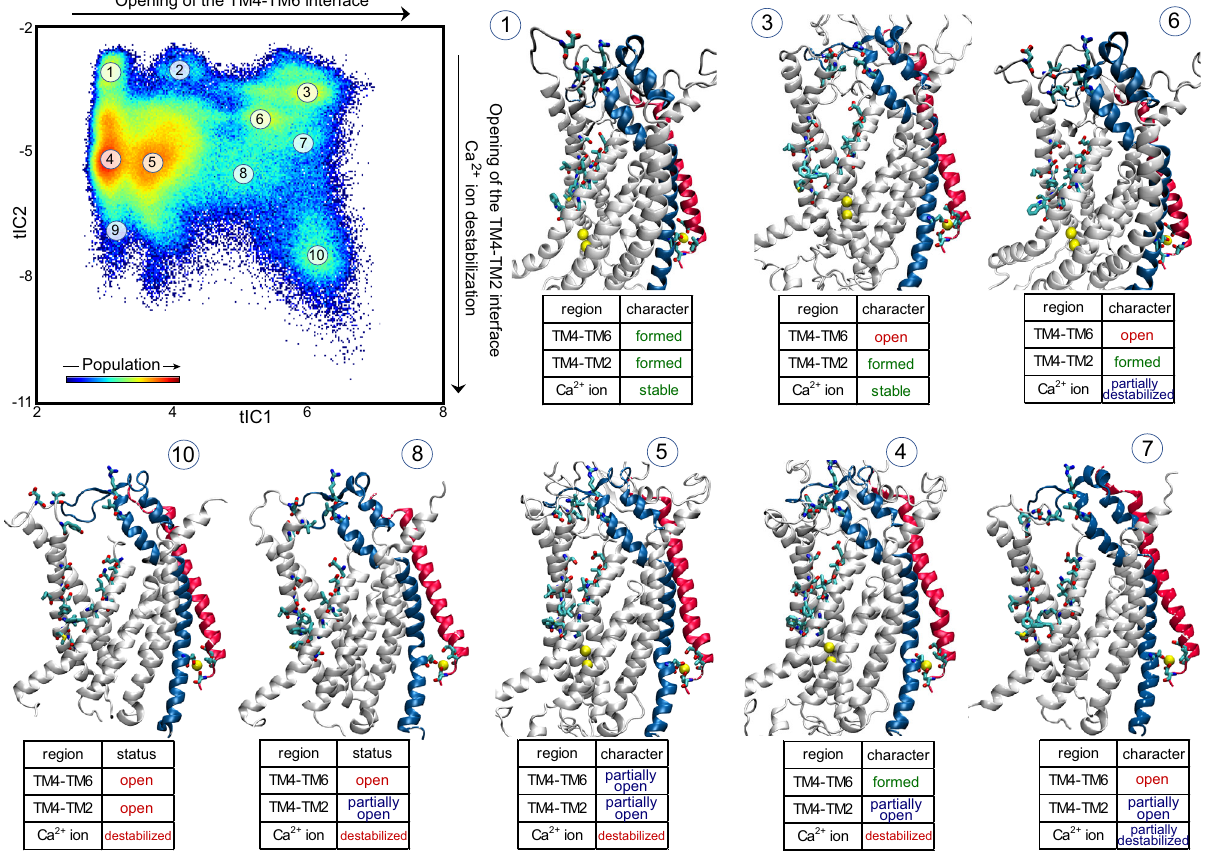
Fig. 3 Structural interpretation of the tICA space features. Projection of all the MD trajectory frames from the adaptive ensemble simulations onto the 2D space spanned by the fi rst two tIC vectors (see also Fig. S3). The color map identi fi es the populations distribution of the different states of mTMEM16F in this tICA space. Representative structures from selected microstates indicated on the tICA map are shown in the molecule models. The table accompanying each model describes the characteristics of the critical regions (TM4 – TM6, TM4 – TM2, and the distal Ca 2 + ion binding site) in the corresponding microstate. Only one protomer of mTMEM16F is shown. TMs 2 and 10 are colored in blue and red, respectively. The Ca 2 + ions are shown as yellow spheres and the relevant residues are drawn in licorice as in Fig. 2a. A more detailed structural quanti fi cation of the microstates is presented in Fig.